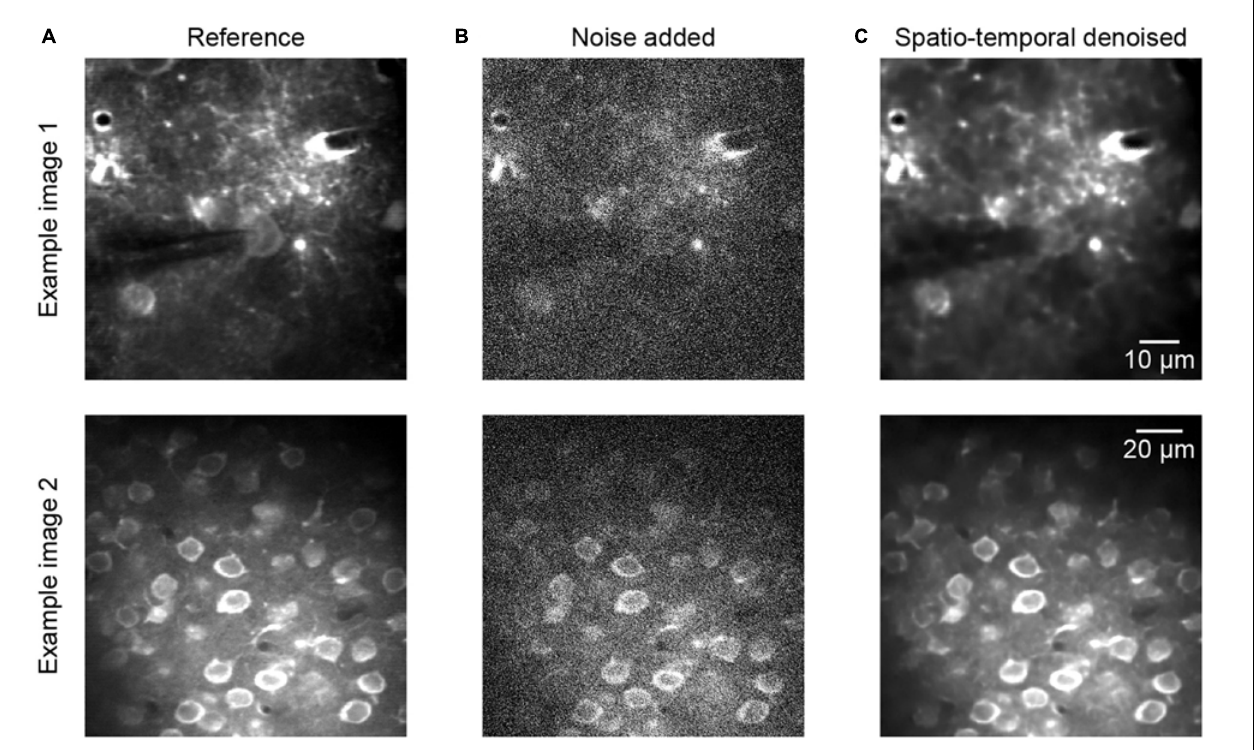
the fourth frame (three replications) as the network target ( n = 900 image